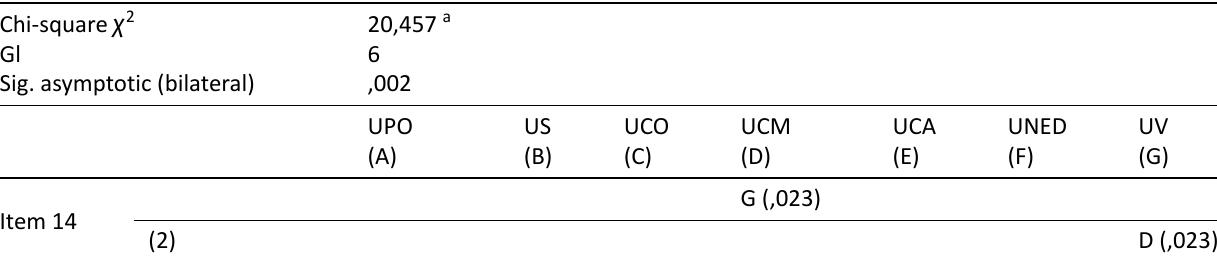
Table 5. Chi‐square and comparisons of proportions (item